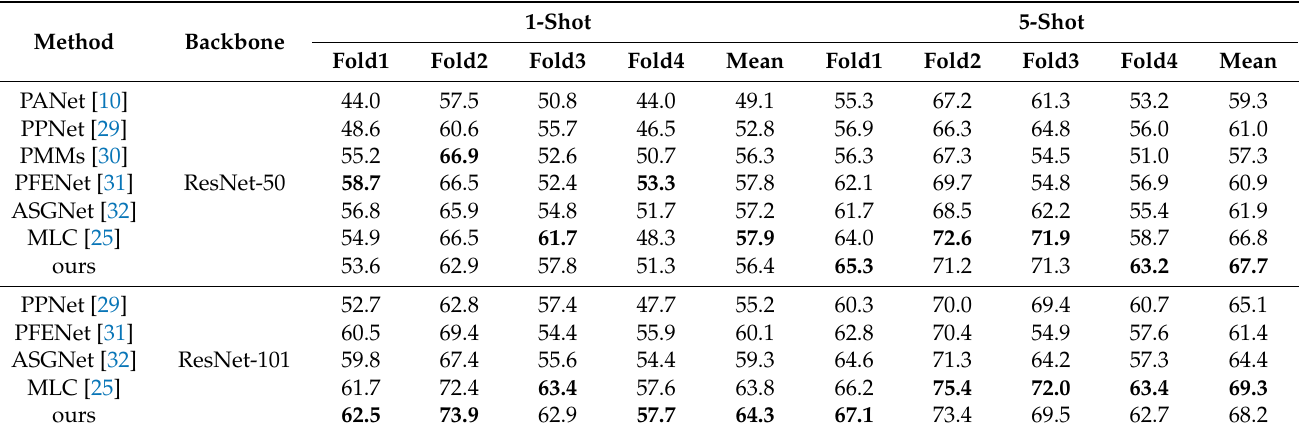
Table 2. Mean-IoU of 1-way on PASCAL-5 i . Bold numbers represent the best data in the comparison experiment.